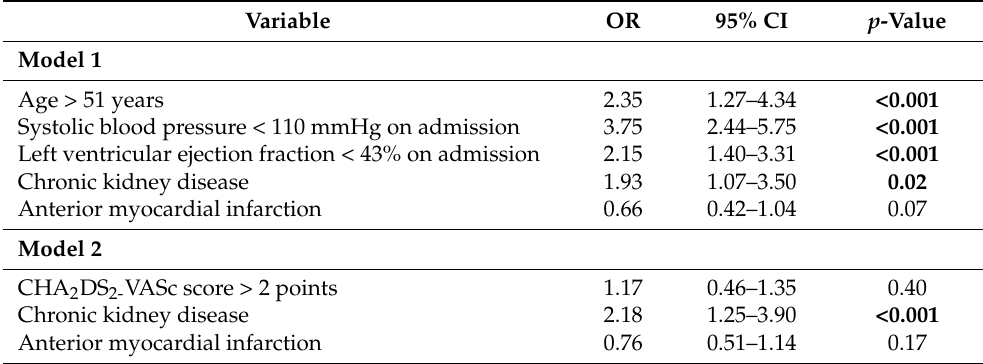
Table 2. Multiple logistic regression analysis to predict the likelihood of ST-segment elevation myocardial-infarction-related arrhythmic complications.